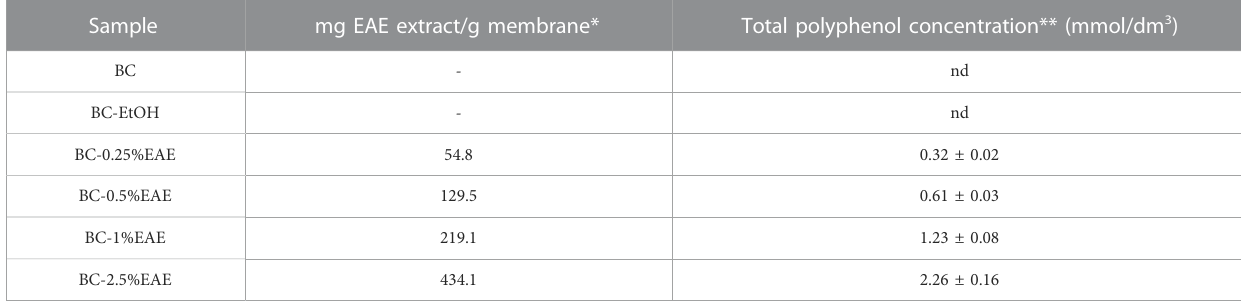
TABLE 1 The plant extract content and total polyphenol accumulation in